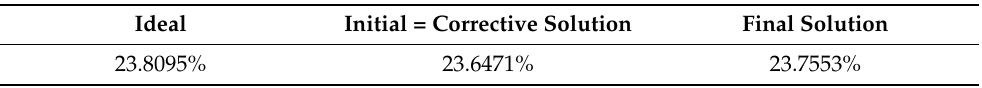
Table 7. Production time percentage for every component yielded from training the model for the spraying cabin